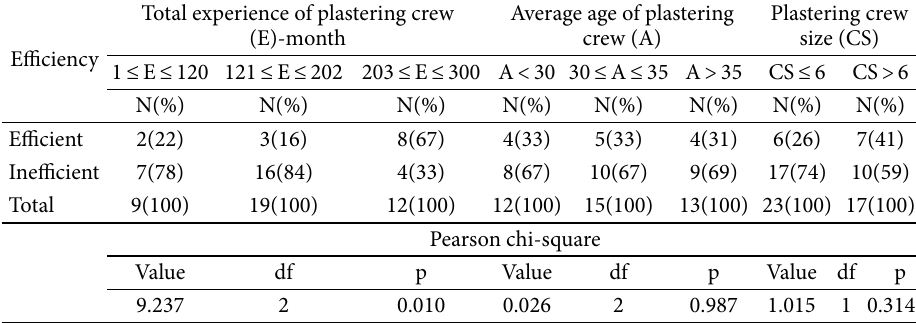
Table 5. Contingency table for efficiency vs. plastering crew characteristics